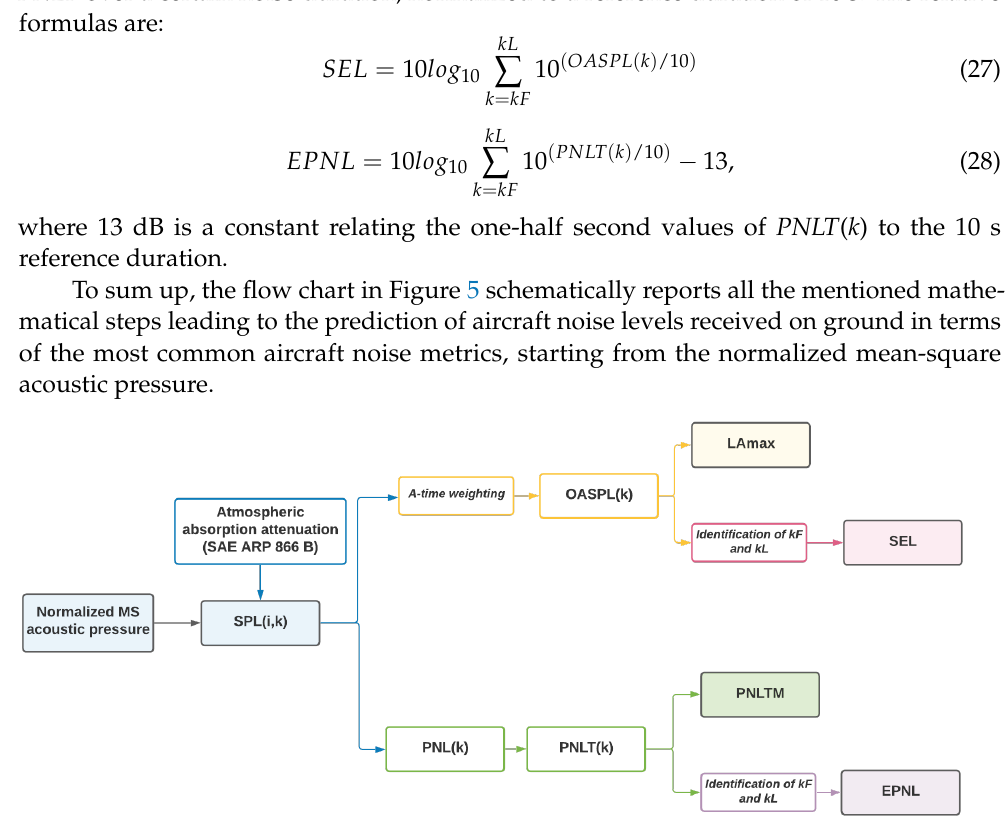
Figure 5. Procedure employed to assess aircraft noise level received on ground in terms of the most common aircraft noise